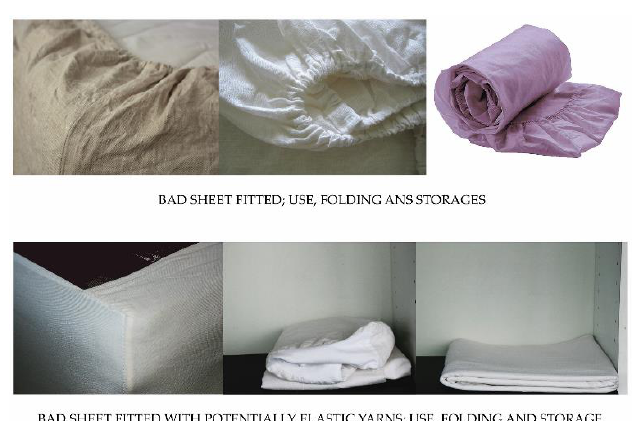
Figure 12. The differences in the use, folding, and storage between two types of bed sheets.